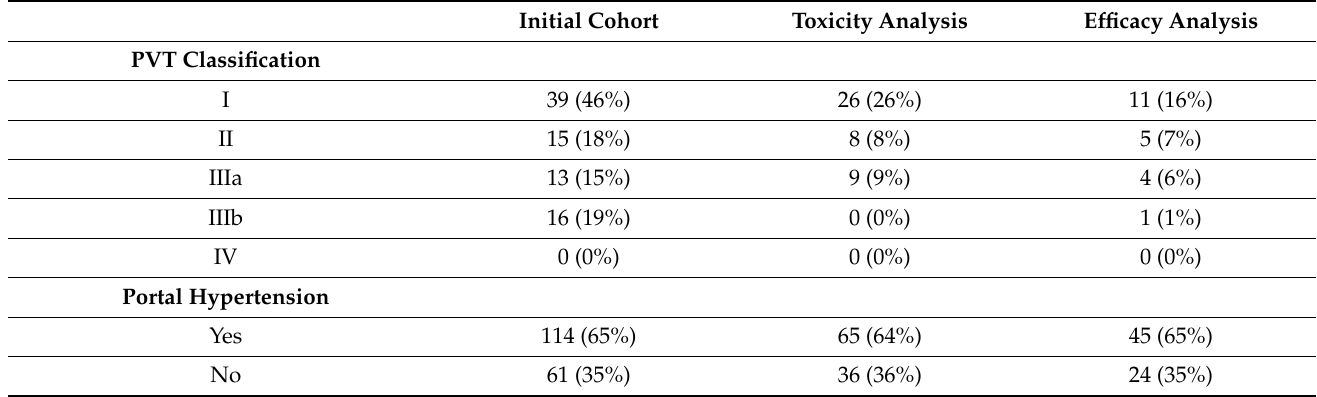
Table 1. Cont. Initial Cohort Toxicity Analysis Efficacy Analysis